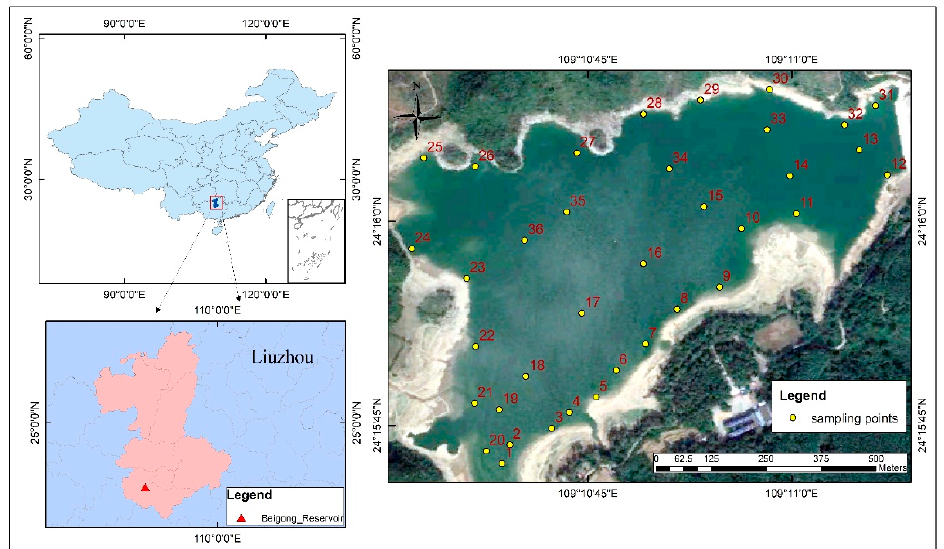
Figure 1. Sampling sites at Beigong Reservoir (BR) in Liuzhou.